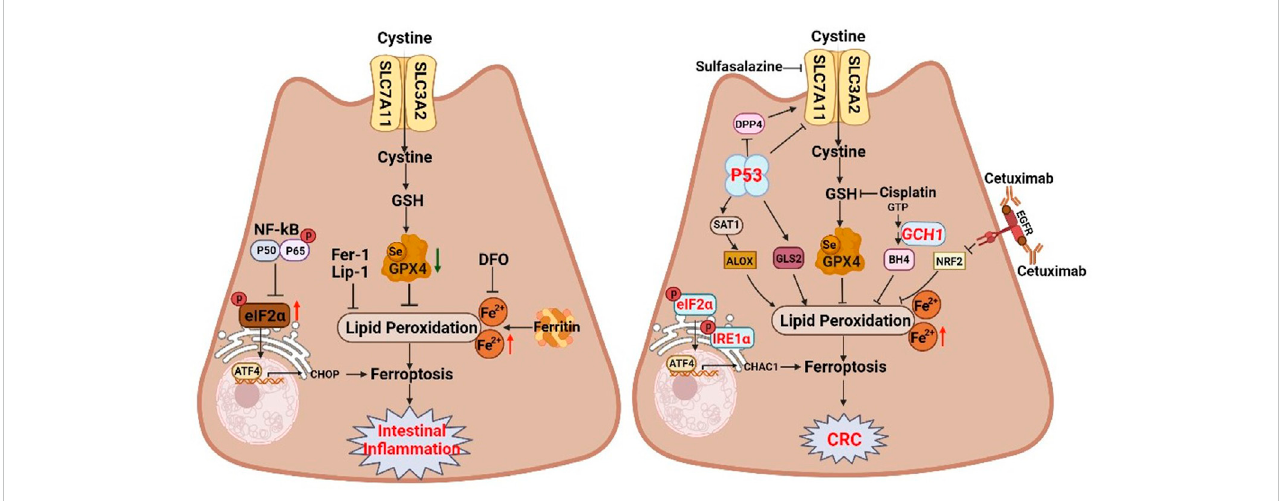
The dual regulatory roles of ferroptosis in in fl ammatory bowel disease and colorectal cancer. Ferroptosis inhibition can attenuate intestinal injury in intestinal in fl ammation. However, inducing ferroptosis with pharmacological activators can inhibit the proliferation of colorectal neoplasms. The schematic diagram shows related ferroptosis regulators and pathways. SLC7A11 solute carrier family 7 member 11, SLC3A2 solute carrier family 3 member 2, GSH glutathione, GPX4 glutathione peroxidase 4, NF-kB nuclear factor kappa B, eIF2 α eukaryotic translation initiation factor 2 subunit alpha, ATF4 activating transcriptionfactor4,CHOPDNAdamageinducibletranscript3,DFOdeferoxamine,Fer-1ferrostatin-1,Lip-1Liproxstatin-1,IRE1 α inositol-requiringenzyme 1 α , CHAC1 ChaC glutathione speci fi c gamma-glutamylcyclotransferase 1, DPP4 dipeptidyl peptidase 4, SAT1 spermidine/spermine N1-acetyltransferase 1, ALOX arachidonate lipoxygenase, EGFR epidermal growth factor receptor, NRF2 NFE2 like bZIP transcription factor